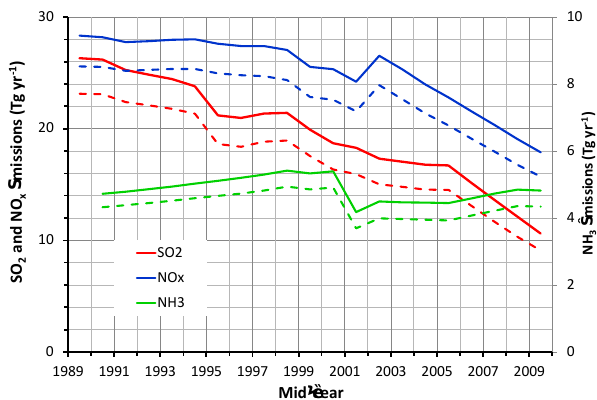
Figure 3. Temporal trends in SO 2 (red), NO x (blue), and NH 3 (green) emitted to the atmosphere over the continental US (EPA, 2013) and over the continental US (EPA, 2013, dashed lines) and over the continental US plus Canada (Environment Canada, 2014; solid lines) during the period of this study.